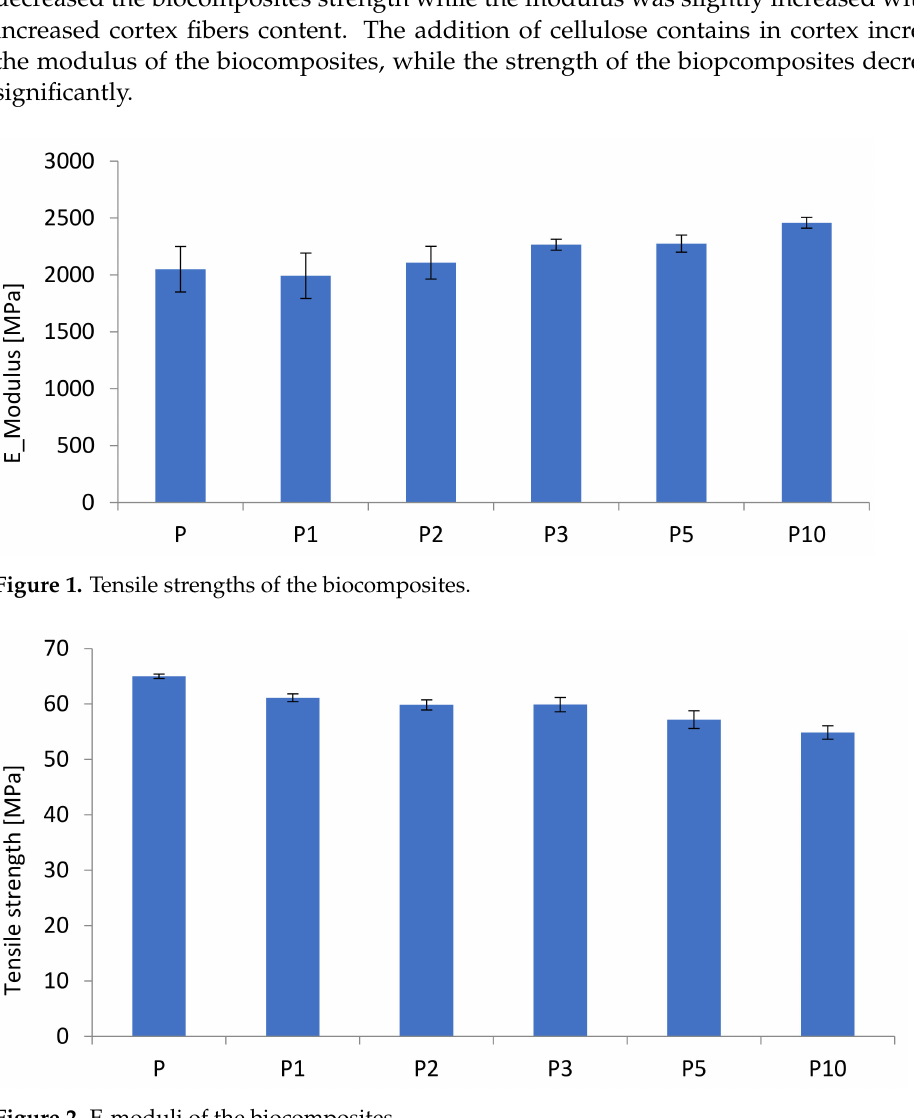
Figure 2. E-moduli of the